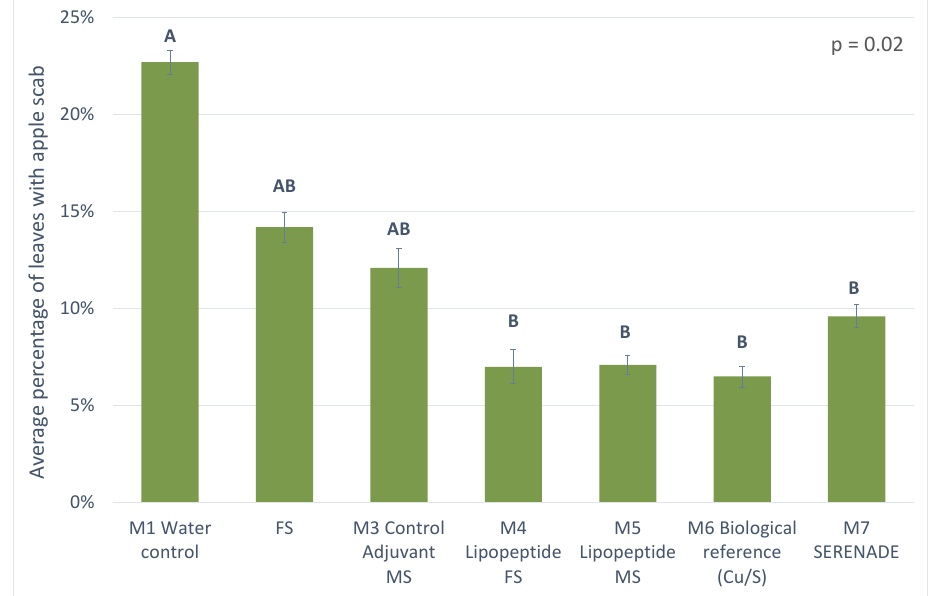
Figure 6. Graphical representation of the levels of leaf scab contamination in the different modalities following the 2018 trials at the end of primary contamination. The different statistical groups are represented by the letters A and B. A rating of AB indicates that this modality belongs statistically to groups A and B.